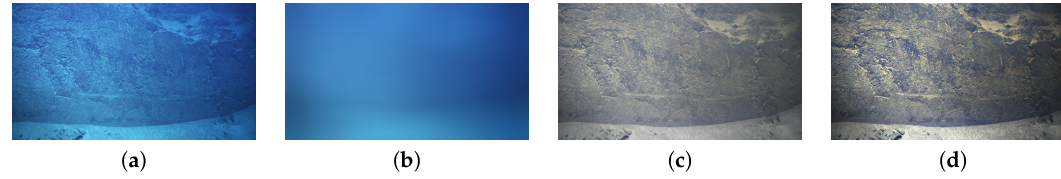
Figure 2. ( a ) Original underwater (UW) image. ( b ) Chromatic components ( α , β ) of the estimated local illuminant. ( c ) White balanced image. ( d ) Final enhanced